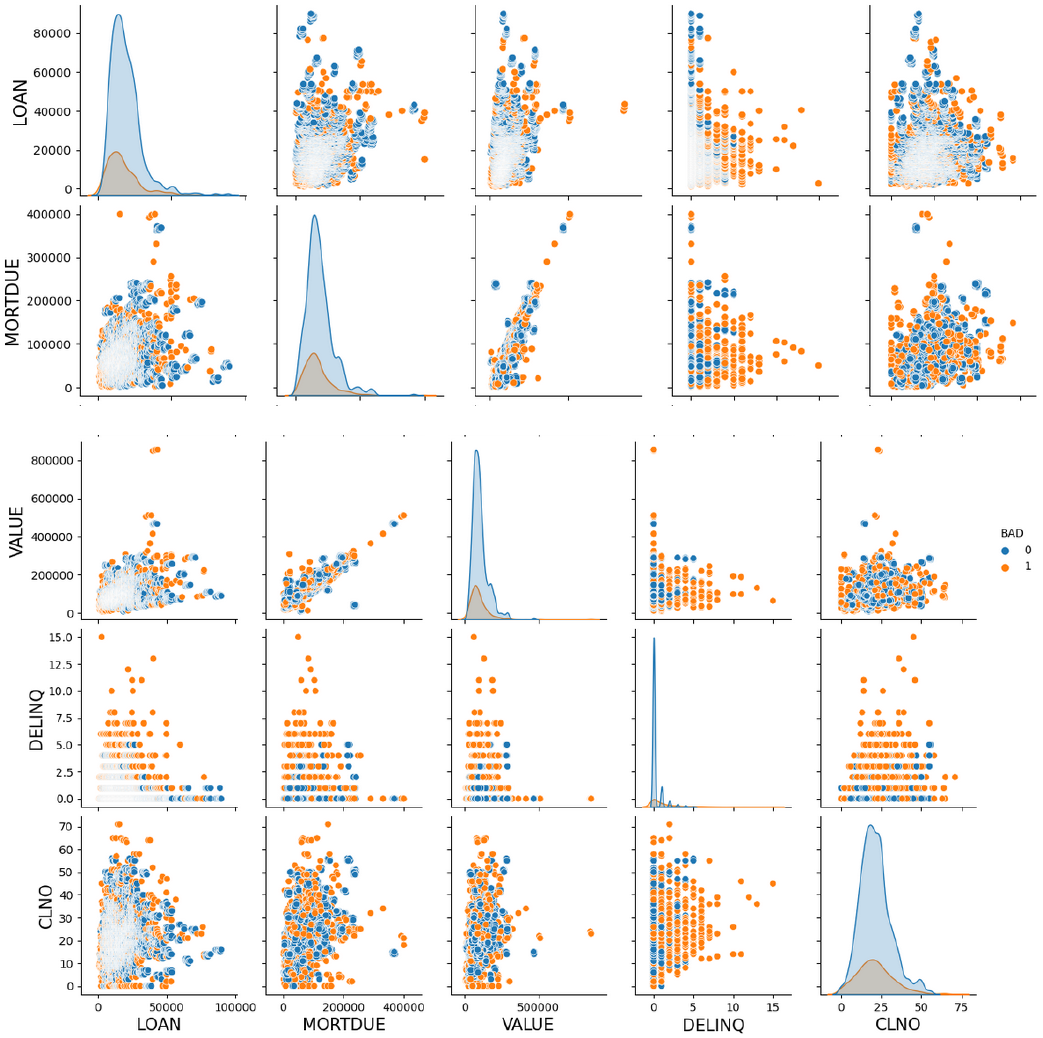
Figure 3. Visual correlation chart for the variables.